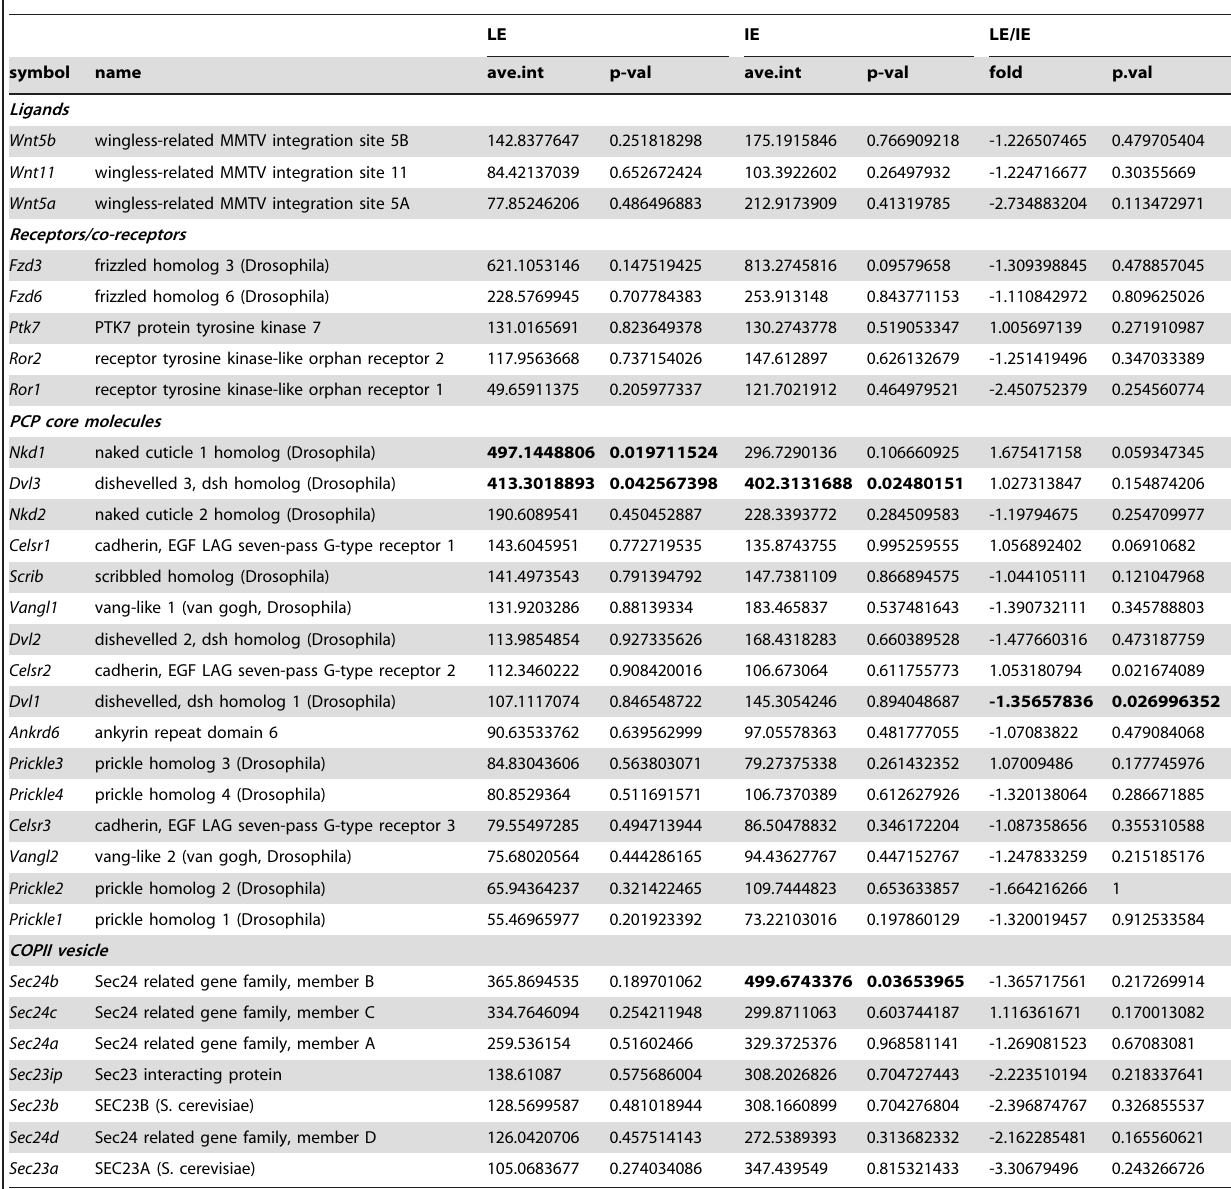
Table 10. Expression of genes in the PCP pathways